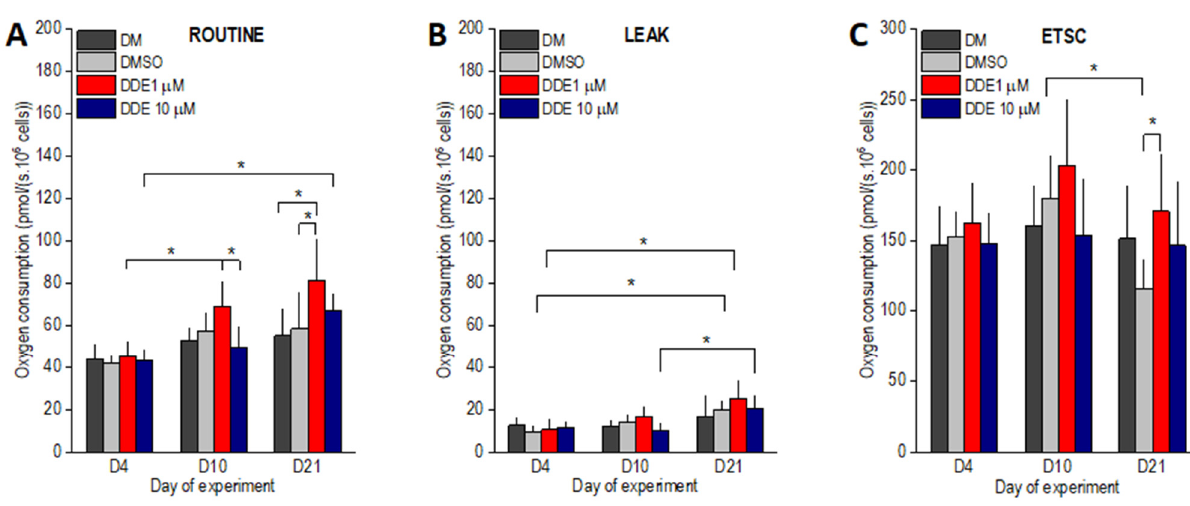
Figure 5. ( A – C ) ROUTINE, LEAK and uncoupled (ETSC) oxygen consumptions of adipocytes differentiating in media containing no additive (DM) or DMSO, DMSO and 1 µ M p,p’-DDE, and DMSO and 10 µ M p,p’-DDE on days 4, 10, and 21 of the experiment. Significant differences * p < 0.05 (Two-way ANOVA followed by a post-hoc Tukey test).